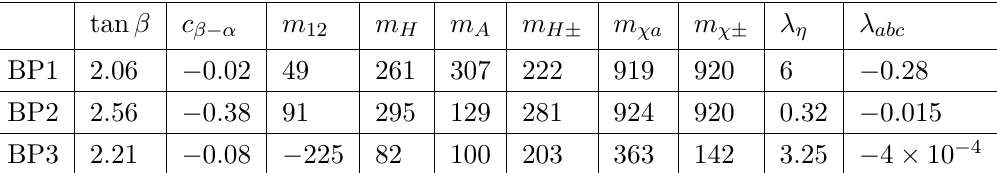
Table 1 . Benchmark points as drawn originally from the numerical scan which correspond to the curves of (cid:12)gure 4. We took the square root of the absolute value of active sector mass parameter m 12 so that a negative value corresponds to (cid:0) m 2 in the scalar potential. All mass parameters are 12 in GeV units.